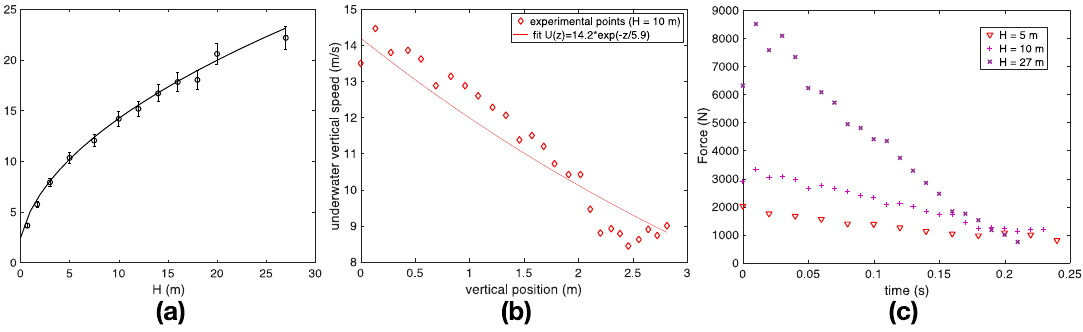
Figure 4. ( a ) Velocity of the diver at the water entry. Open circles show the experimental values for several dives from different platform heights H, ranging from 0.7 to 27 m and the solid line gives the predicted value 𝑈 (cid:2868) = (2𝑔𝐻 (cid:3040)(cid:3028)(cid:3051) ) (cid:2869)/(cid:2870) . ( b ) Evolution of the underwater speed (U) with the vertical position (z). Red diamonds show experimental points and the line represents the fit of the theoretical expression given by Equation (1). ( c ) Force undergone by the diver underwater in function of time, for three different initial heights H = 5, 10 and 27 m, calculated from Equation